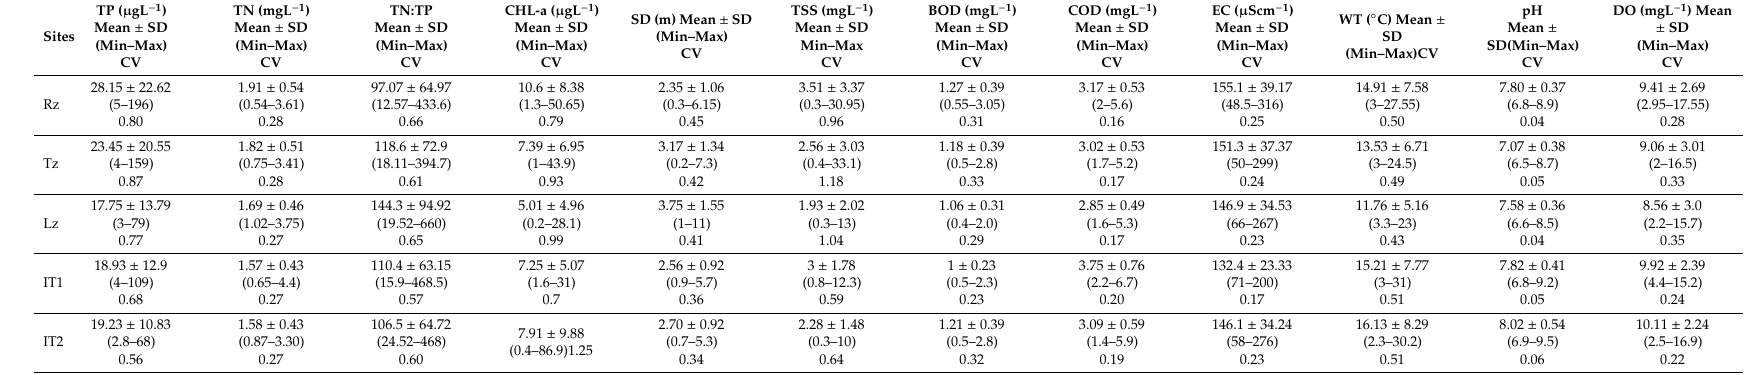
Table 1. Zonal variations of water quality parameters in the Daecheong Reservoir during 2000–2018 (TP: total phosphorus, TN: total nitrogen, CHL-a: chlorophyll-a, SD: Secchi depth, TSS: total suspended solids, BOD: biological oxygen demand, COD: chemical oxygen demand, EC: electrical conductivity, WT: water temperature, pH: hydrogen ion concertation, DO: dissolved oxygen, Rz: riverine zone, Tz: transitional zone, Lz: lacustrine zone, IT1: drinking water intake tower 1, IT2: drinking water intake tower 2, SD: standard deviation, Min: minimum, Max: maximum, and CV: coe ffi cient of variation; monthly data from 2000–2018 were used in Rz–IT2 to make the summary statistics of water quality